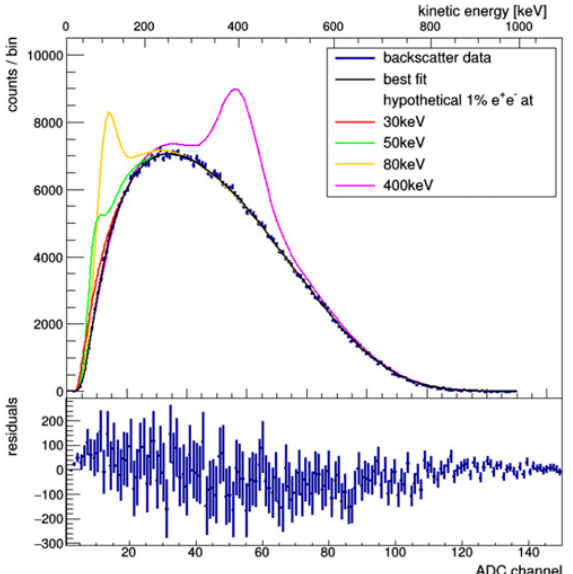
Figure 5. Reanalysis of events of electrons backscattered from the P ERKEO II detector system in a measurement of the beta correlation coefficient A and a search for an additional hypothetical dark matter e + e − signal. Shown is a fit to the spectrum (with the residuals in the lower graph) and the expected spectra for a hypothetical 1% e + e − branch at 30keV, 50 keV, 80keV, and 400 keV. The backscatter signal makes up approximately 4% of the total beta decay